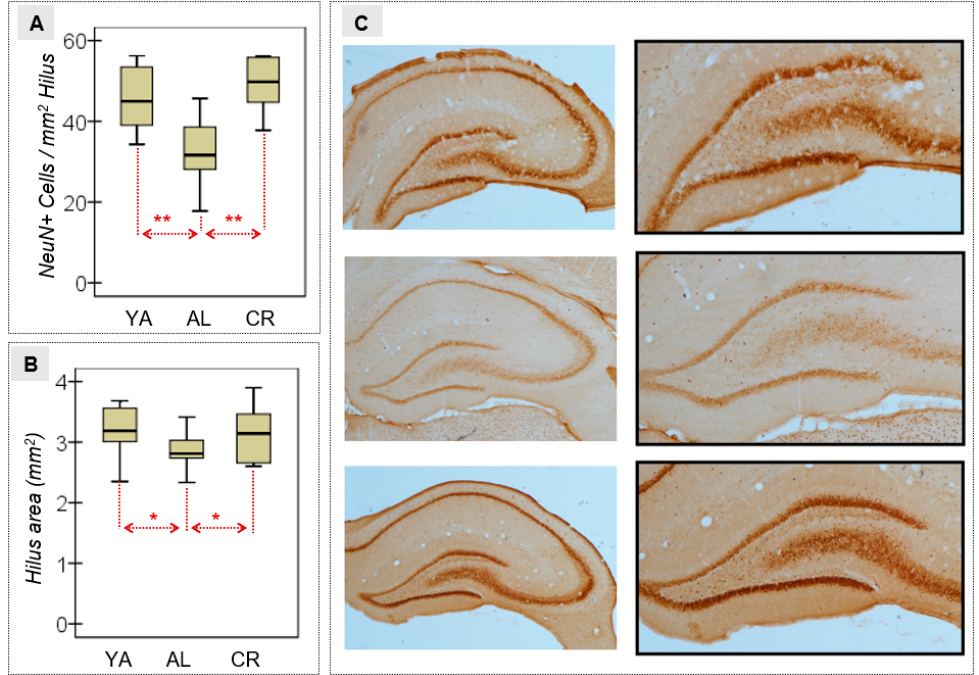
Figure 4. ( A ) Quantification of the neural density in the hilus (proportion of NeuN-positive cells over the hilus area). ( B ) Estimation of the hilus area for each experimental group measured in mm 2 . ( C ) NeuN immunostaining with DAB in the hilus. Representative images of the NeuN staining in the hippocampus (HPC) (brown) with high magnification images of the hilus (boxed). One section per animal from each group was selected to illustrate the data. Scale bars = 500 μ m. YA, young adult (top); AL, ad libitum (middle); CR, caloric restriction (bottom); * Mild-–moderate effect size (| d | > 0.50); ** Large–high effect size (| d | > 0.80).